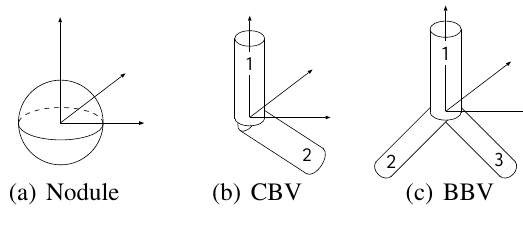
Figure 2. 3-D deformable object models that represent nodules, curved blood vessels (CBV) and bifurcated blood vessels (BBV),